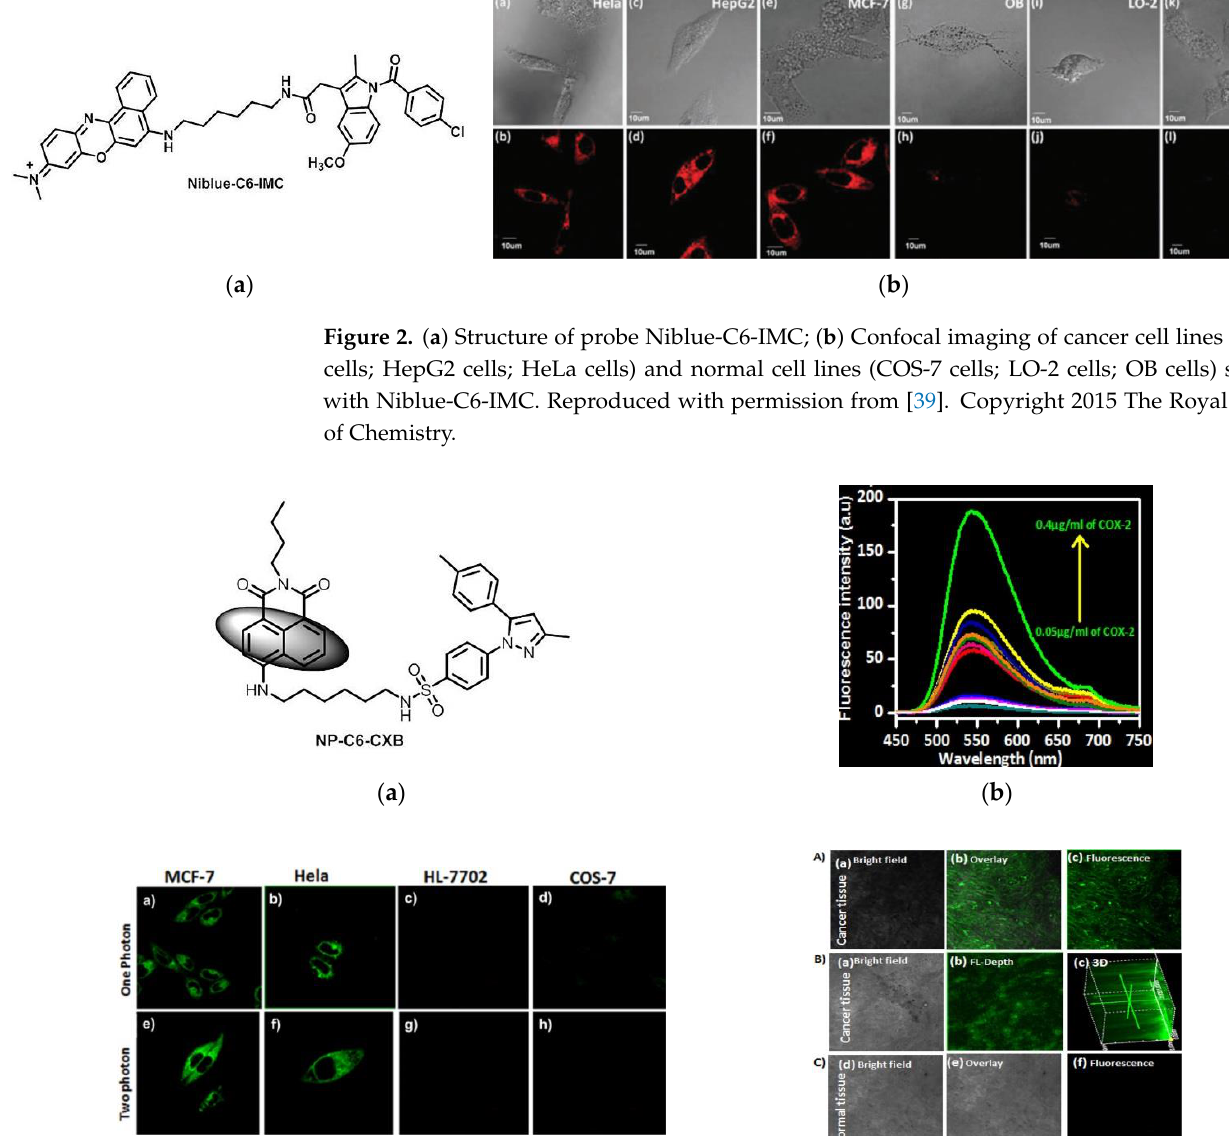
Figure 2. ( a ) Structure of probe Niblue-C6-IMC; ( b ) Confocal imaging of cancer cell lines (MCF-7 cells; HepG2 cells; HeLa cells) and normal cell lines (COS-7 cells; LO-2 cells; OB cells) staining with Niblue-C6-IMC. Reproduced with permission from [39]. Copyright 2015 The Royal Society of Chemistry.